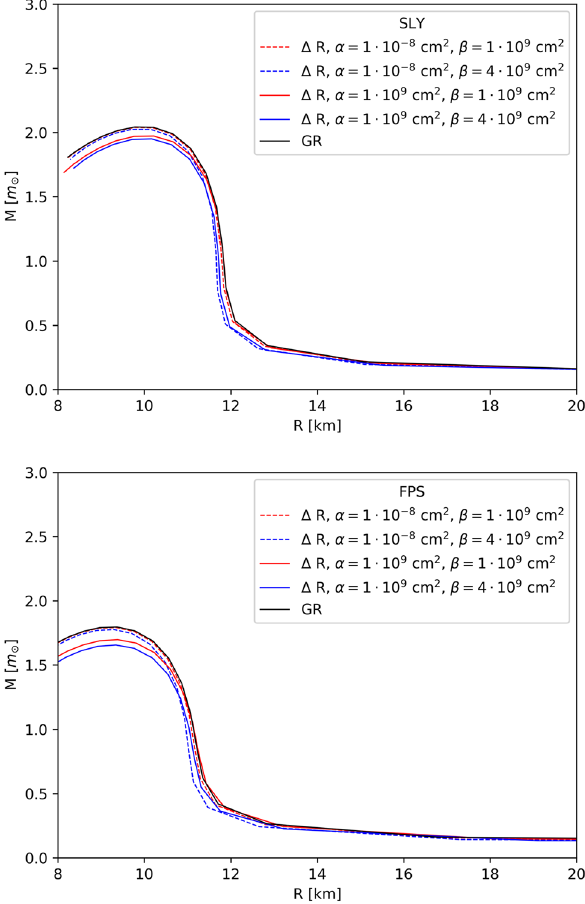
Fig. 12 Mass-radius relation for f ( R , Q ) = R + α R 2 + β Q for SLY (upper panel) and FPS (lower panel)